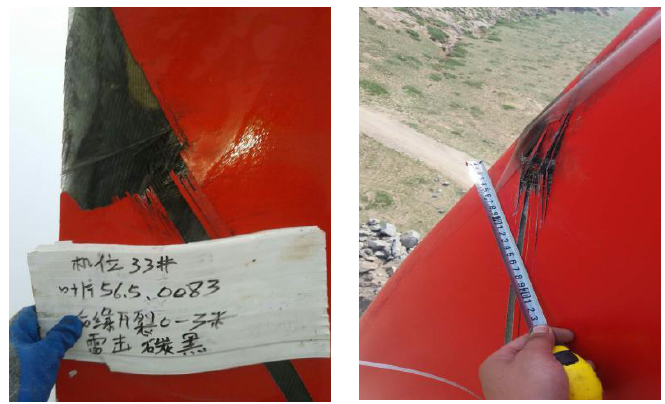
Figure 1. Lightning damage of wind turbine blades (Picture source: Blade manufacturers).